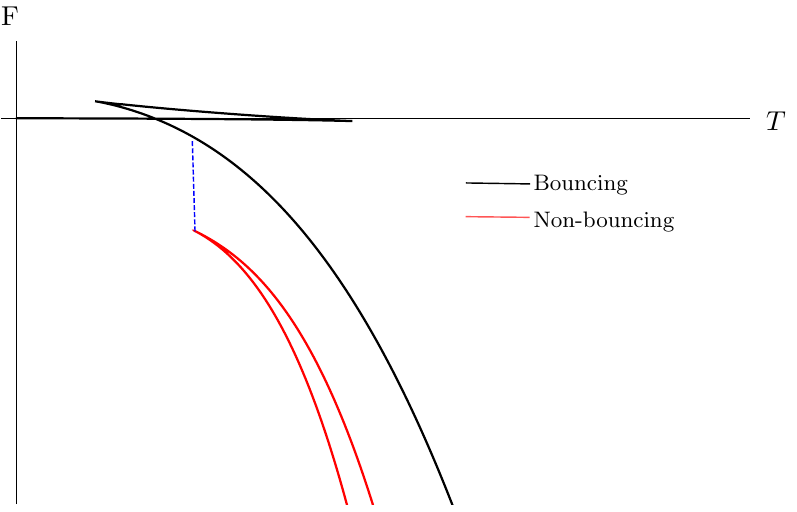
Figure 3 . Phase diagram of j < 0 black holes in the model with bouncing vacuum solution. Bouncing black holes dominate at low temperature, then the free energy F jumps by a (cid:12)nite amount (dashed blue line) on the non-bouncing